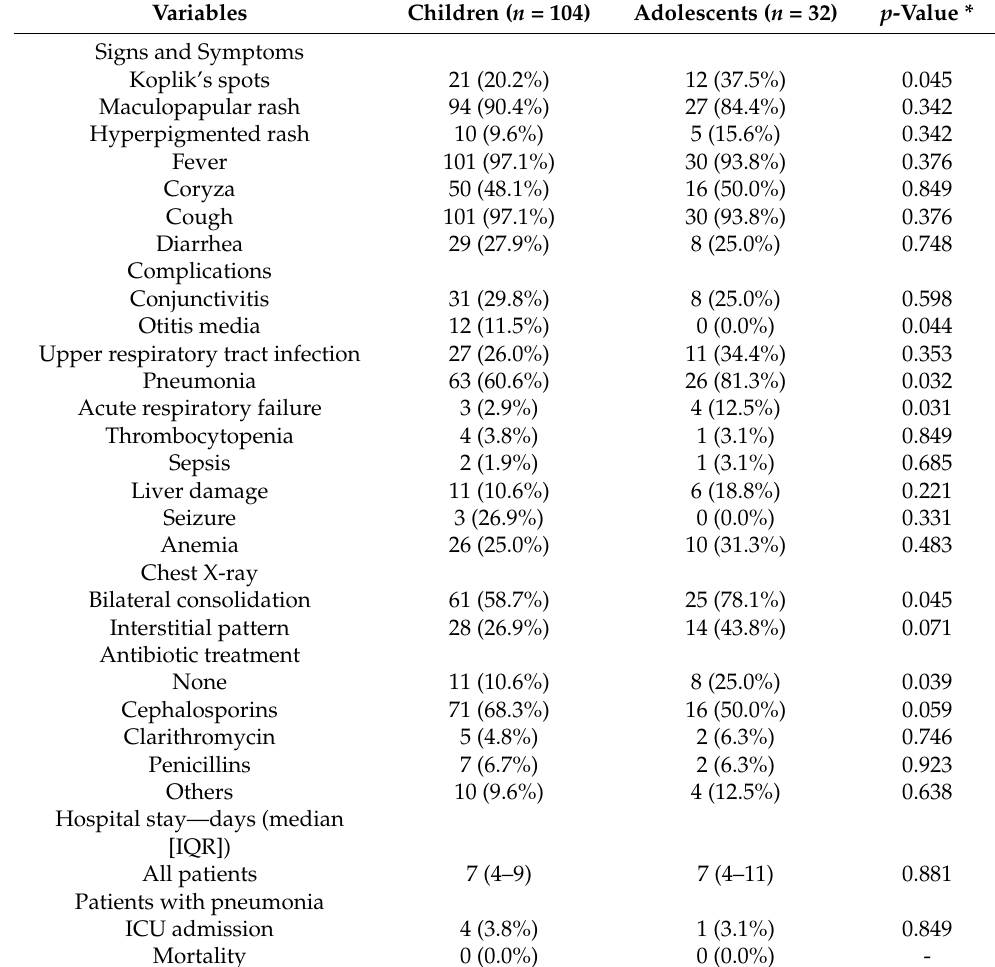
Table 2. Comparison of clinical characteristics, complications, and outcomes of patients admitted with measles, stratified by duration of hospital stay.